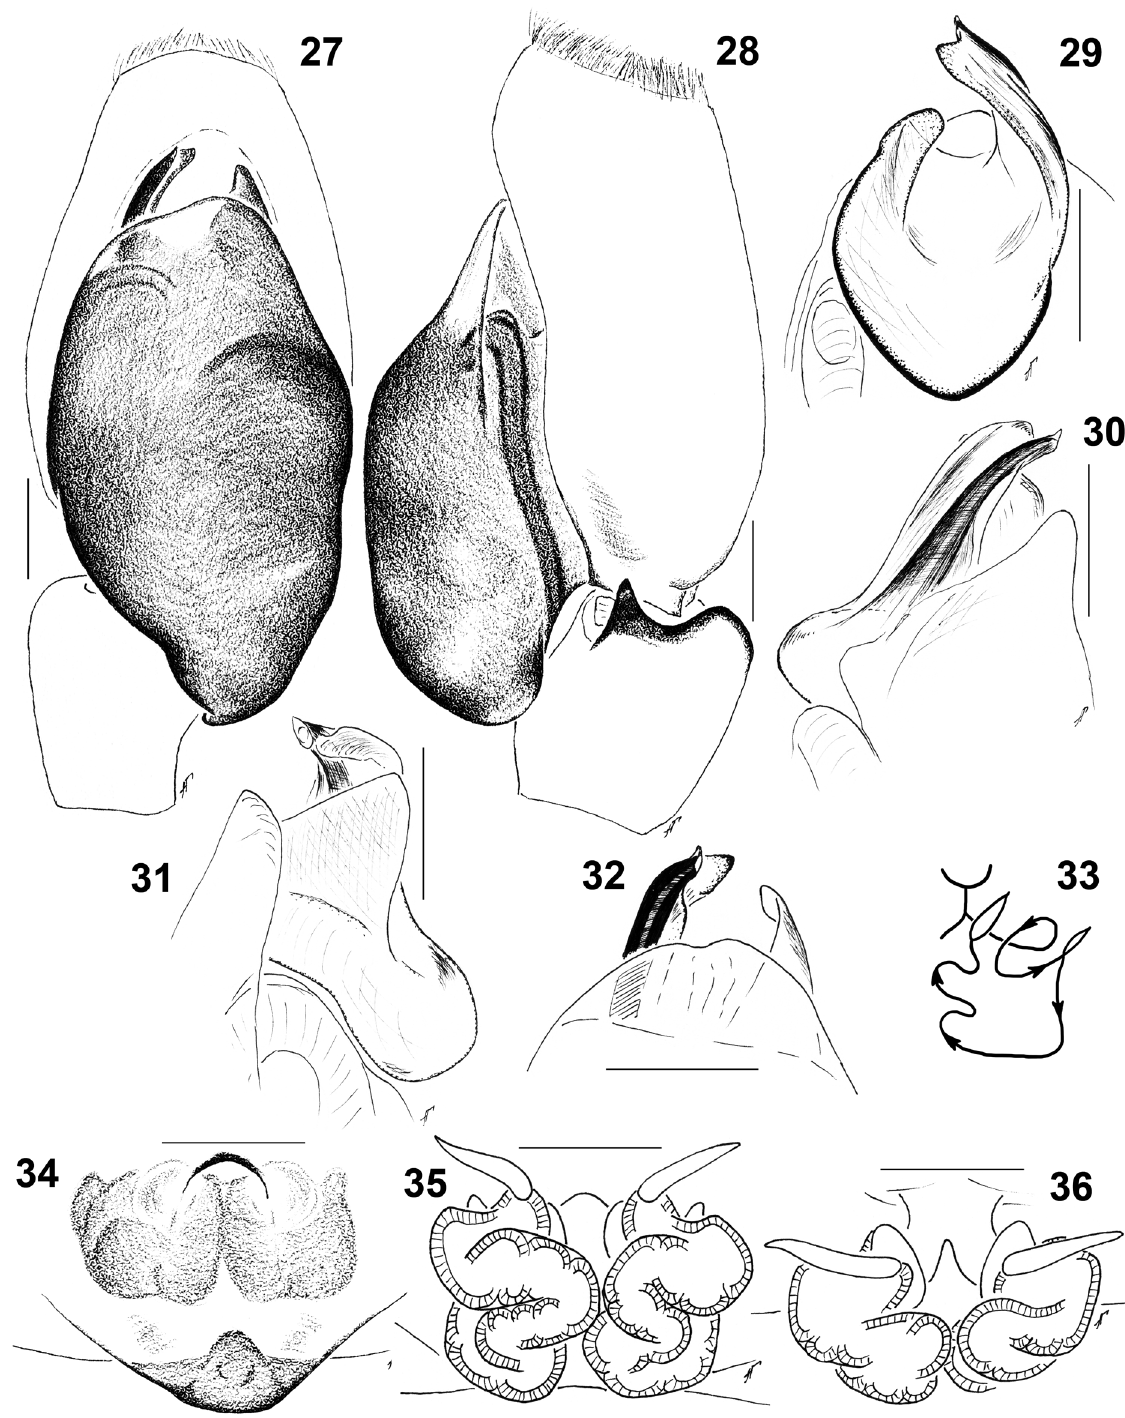
Figs. 27–36. Manzuma botswana gen. et sp. nov., holotype, ♂ (27–28), paratype, ♂ from Maxwee (29– 32), paratype, ♀ from Shorobe Lagoon (33–36). 27–28 . Male palp. 27 . Ventral view. 28 . Retrolateral view. 29–32 . Embolic division. 29 . Dorsal view. 30 . Prolateral view. 31 . Retrolateral view. 32 . Ventral view. 33 . Diagrammatic course of the insemination ducts. 34 . Epigyne, ventral view. 35–36 . Spermathecae. 35 . Dorsal view. 36 . Apical view. Scale bars: 0.1